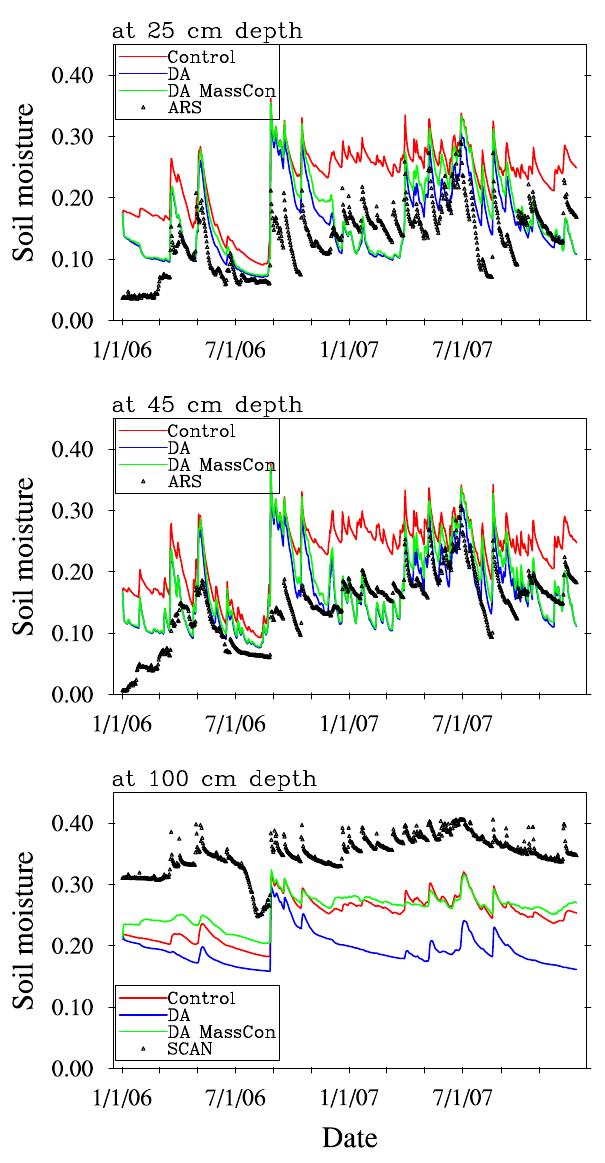
Fig. 4. Comparison of basin averaged daily soil moisture (cm 3 cm − 3 ) from Control, DA, and DA MassCon, interpolated at 25, 45 and 100cm depths, with measurements from ARS stations and the SCAN